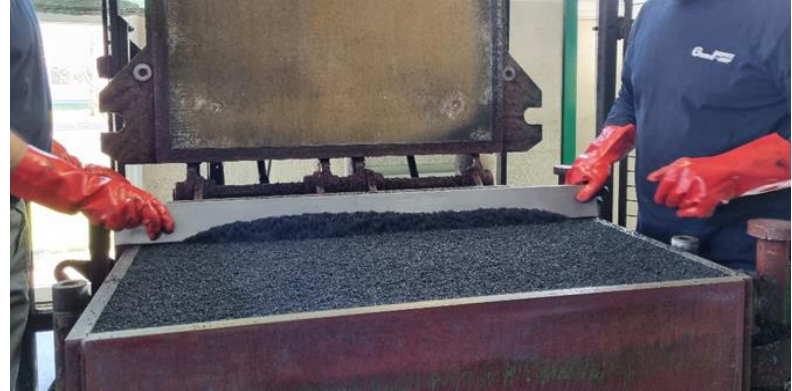
Figure 3. Press mold. After 4 min, the tile was taken out of the mold and placed on its side to cool. Recycled rubber tiles are mostly composed of 20% of granules of a size 0.5 – 2.0 mm and 80% of granules of a size 2.0–3.5 mm. The final product is shown in Figure 4.